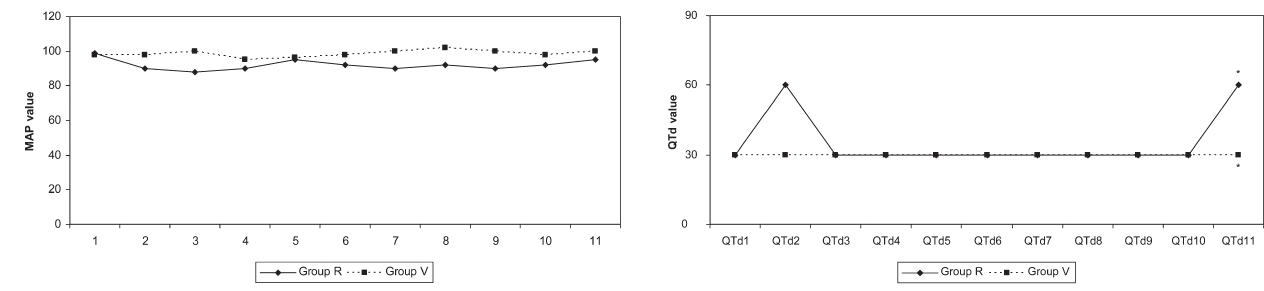
Figure 2 - MAP values in the two study groups (mmHg).